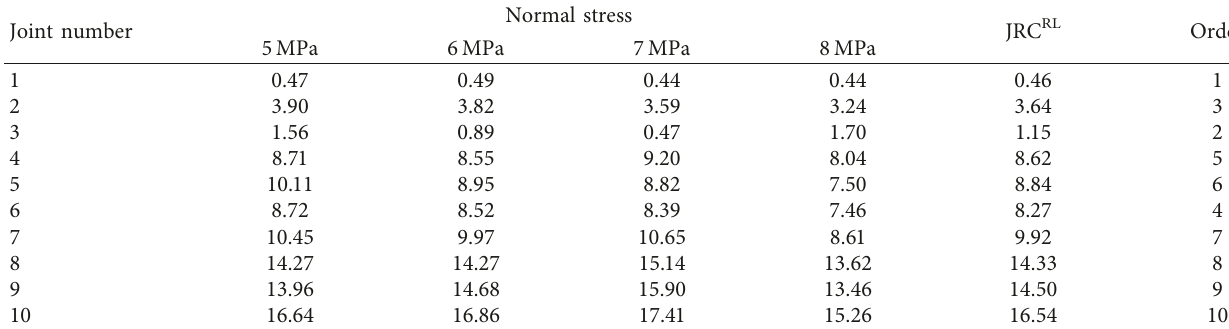
Table 8: JRC RL values of 10 standard joint